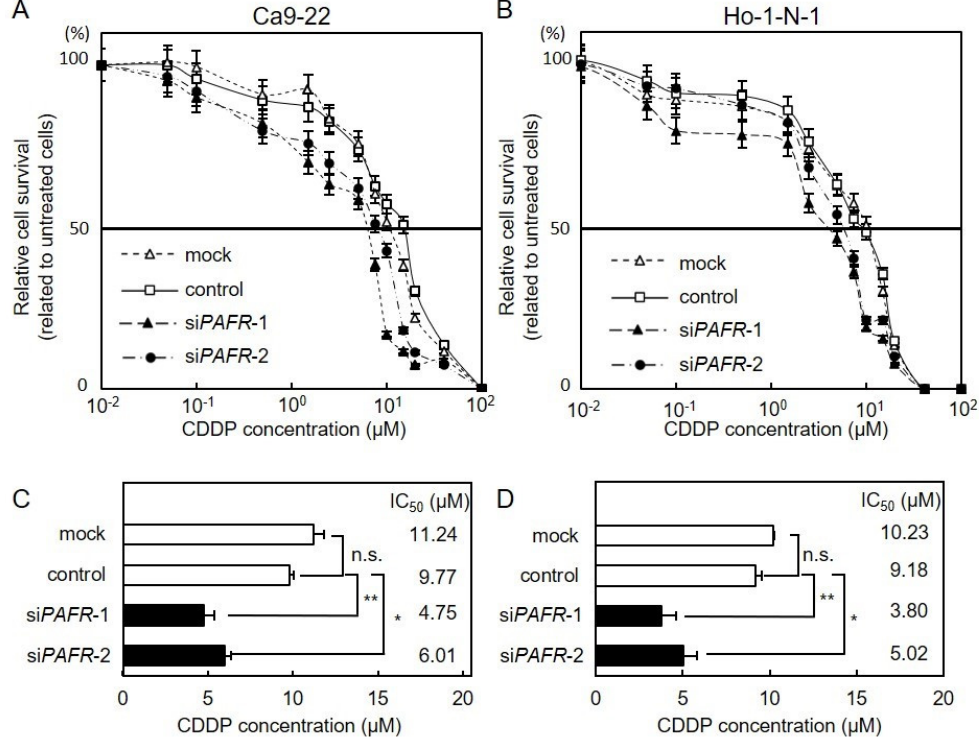
Figure 4. Effect of PAFR knockdown on CDDP sensitivity. ( A , B ) si PAFR -transfected cells were seeded in 96-well plates at a density of 1 × 10 4 cells/well and treated with CDDP (0.01–1000 µM) for 48 h, followed by a cellular viability assay. Values are expressed as the mean ± standard error of the mean in relation to untreated cells (Ca9-22 ( A ) and Ho-1-N-1 ( B )). ( C , D ) IC 50 of CDDP in si PAFR -transfected cells. A significant decrease in IC 50 was observed in si PAFR -transfected cells compared with control (Ca9-22 ( C ) and Ho-1-N-1 ( D ); Unpaired t -test; *, p < 0.01; **, p < 0.001; n.s., no significant difference). CDDP, cisplatin.